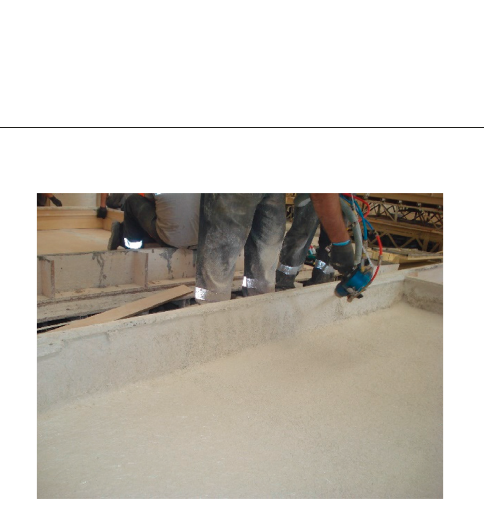
Figure 1: Spraying process. Table 2: The chemical and physical properties of CEM I 52.5 R